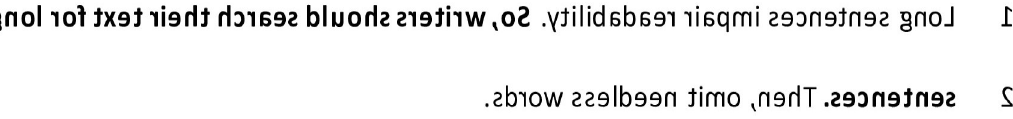
Fig 2. Conceptual visualization of mirror-reversed text. Participants judged whether the target sentence (bolded) on each trial contained more or fewer than 17 words.